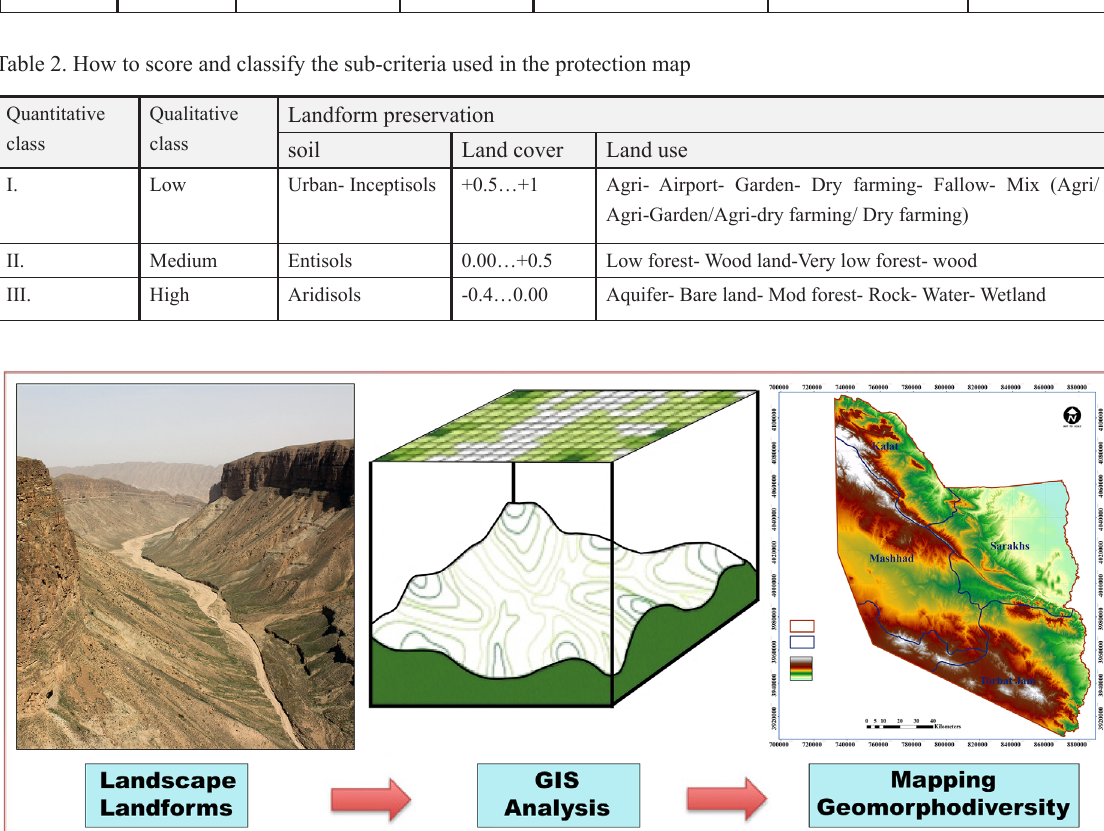
Figure 3 . Map preparation steps in Arc GIS